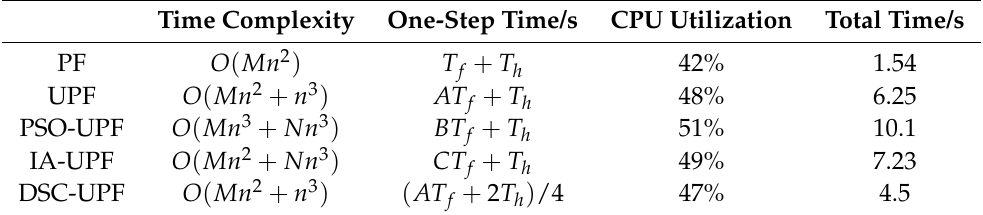
Table 2. Computational performances of PF, UPF, PSO-UPF, IA-UPF and DSC-UPF. Time